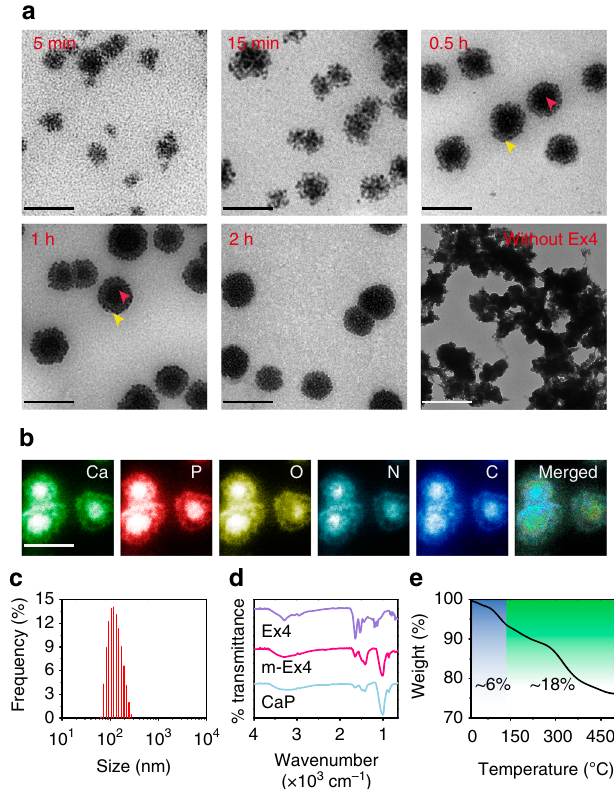
Fig. 2 Characterization of m-Ex4 nanoparticles. a TEM images of m-Ex4 nanoparticles at different time points. The sans peptide group was tested as a control. Red arrows indicate the center; yellow arrows indicate the periphery. Scale bar, 200 nm. b Elemental mapping of intermediate at 0.5 h during Ex4 mineralization reaction. Scale bar, 200 nm. c Dynamic light scattering (DLS) analysis of m-Ex4 particles. d The FTIR spectrum of free Ex4, control calcium phosphate, and m-Ex4 nanoparticles. e Thermogravimetric analysis (TGA) of m-Ex4 particles. Blue highlighting indicates the water loss and green highlighting indicates the organic component